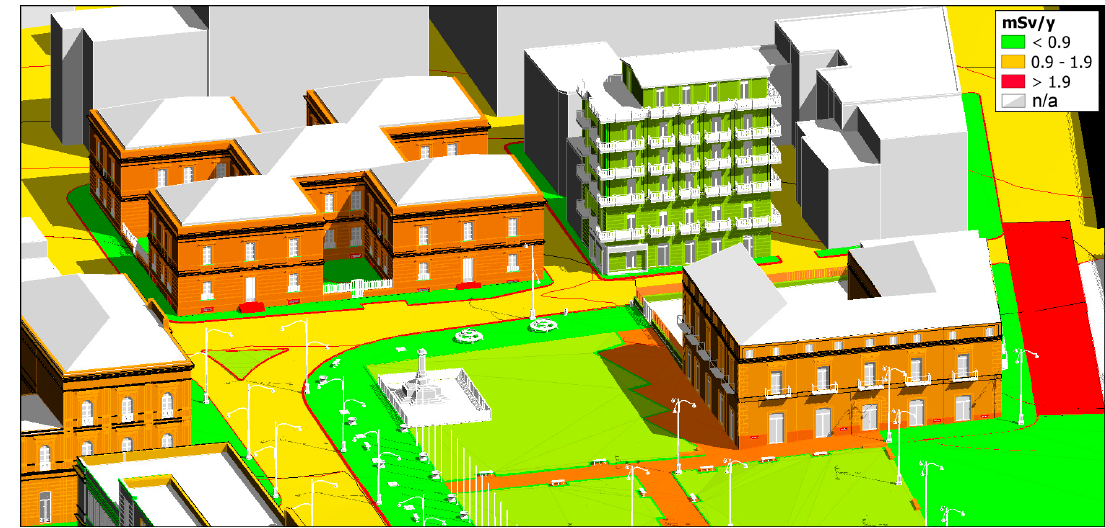
Figure 3. Pompei, Bartolo Longo Square. City Information Modelling (CIM) axonometric view, towards eastern side, categorized with Yearly Equivalent Dose proceeding from flooring and building materials.